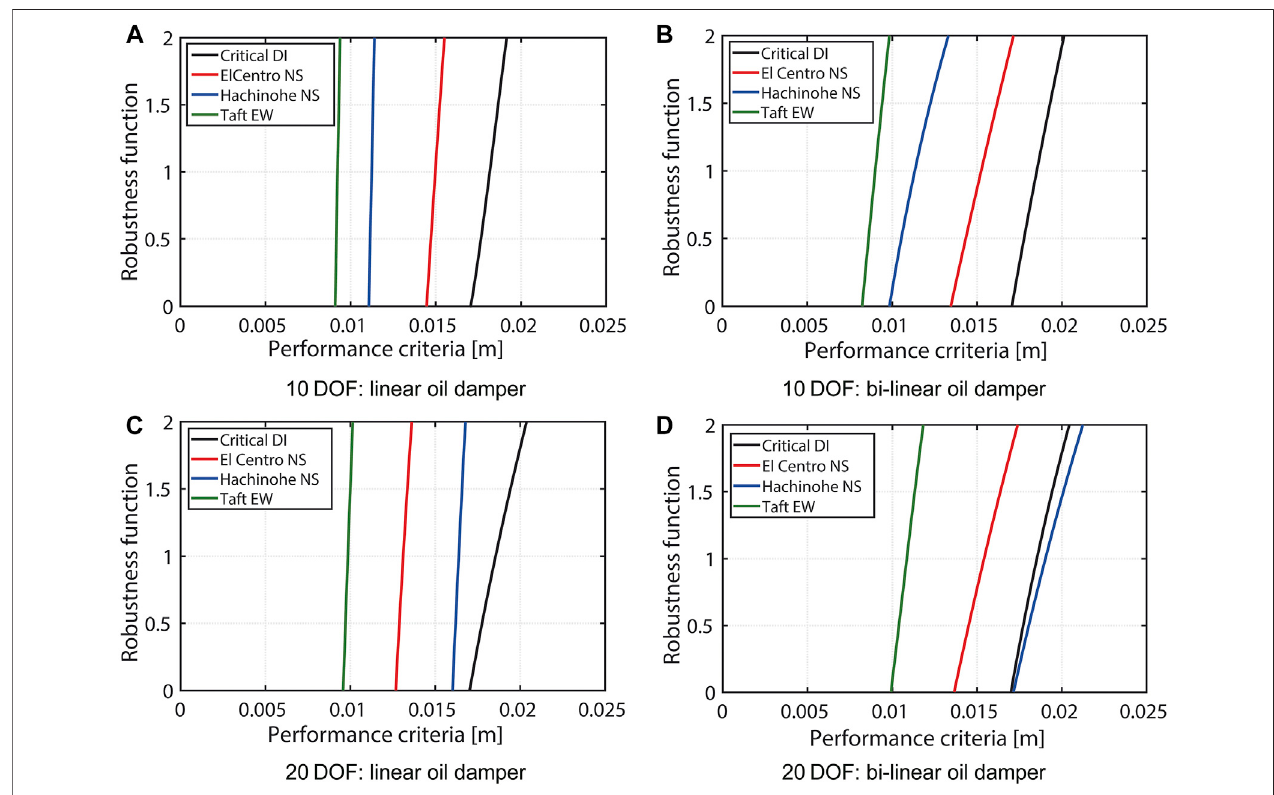
FIGURE13| Comparisonofrobustnessfunctionsforordinaryoptimaldamperplacementandrobustoptimaldamperplacementundercriticaldoubleimpulseand design ground